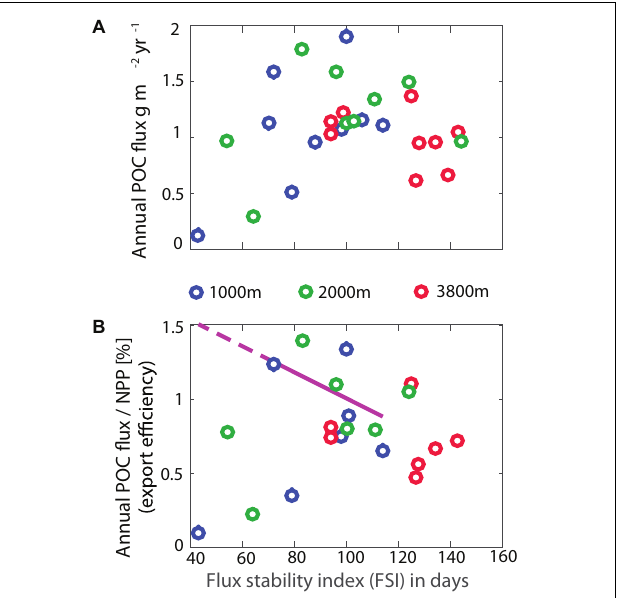
FIGURE 6 | Comparisons of POC flux (A) and transfer efficiency (B) with the flux stability index (FSI) revealed no significant correlations. The pink dashed line shows the relationship between transfer efficiency and FSI proposed for non-polar regions by Lampitt and Antia (1997).